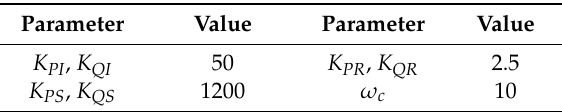
Table 1. Main Parameters of the IRSMC DPC Controller.